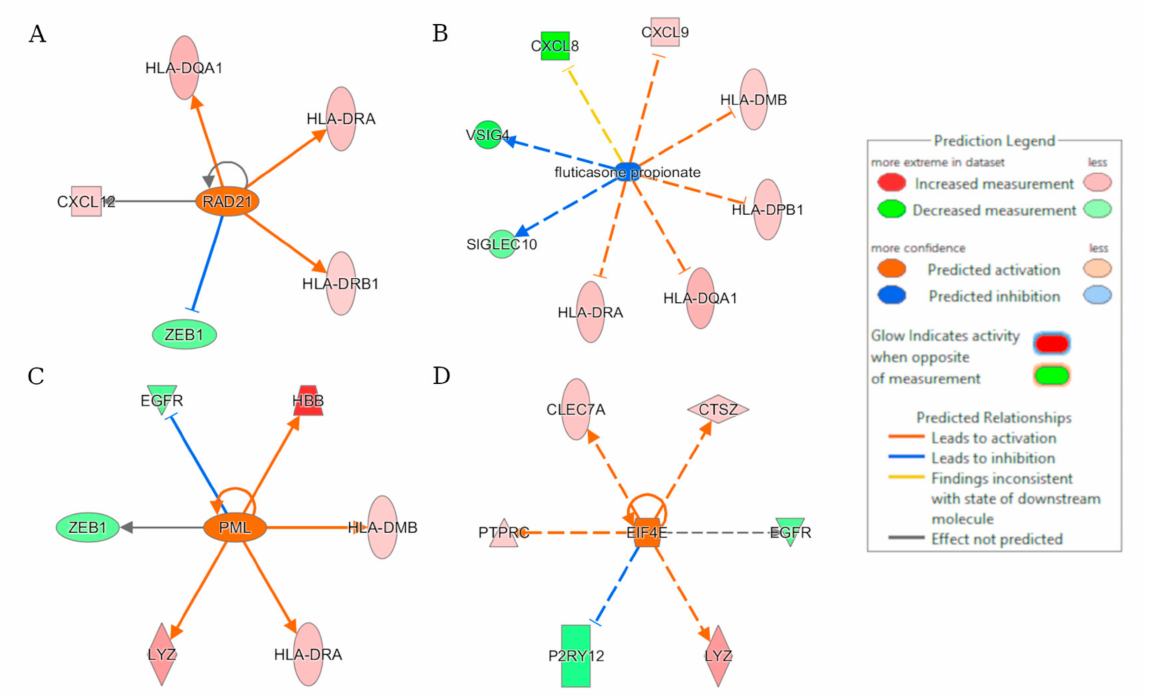
Figure 4. Results of the regulator effects analysis based on the DEGs. Predicted upstream regulators of the recGBM IDH-wildtype phenotype included ( A ) RAD21; ( B ) fluticasone propionate; ( C ) PML; and ( D )